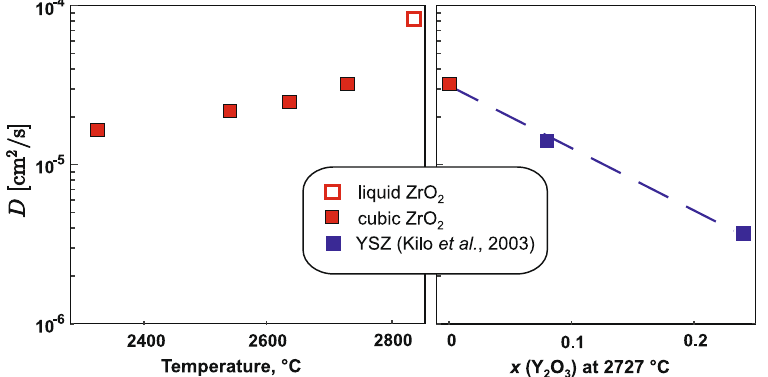
Figure 5. Oxygen diffusion coefficients in pure zirconia computed in this work compare with values for YSZ with 8% and 24% Y 2 O 3 extrapolated to 2727 °C from Kilo et al . 41